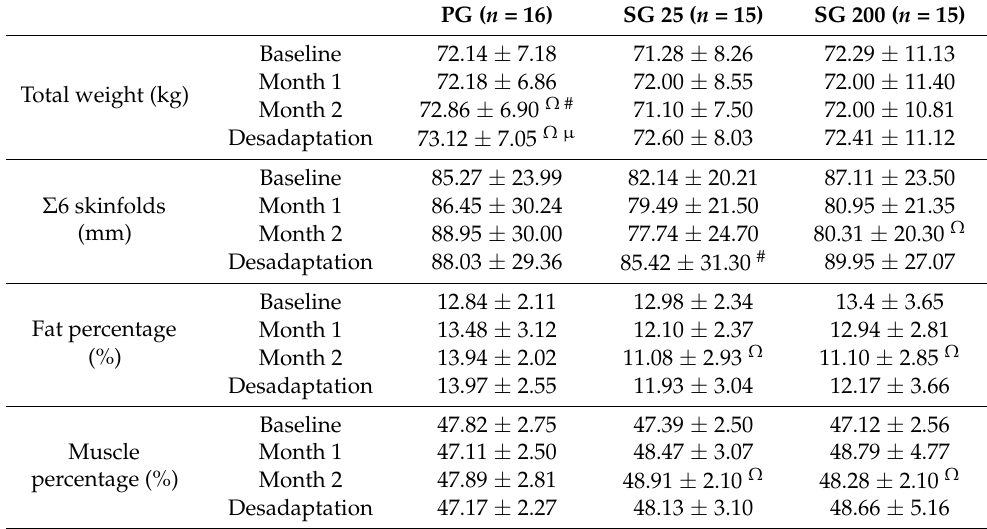
Table 3. Anthropometric values during the study.